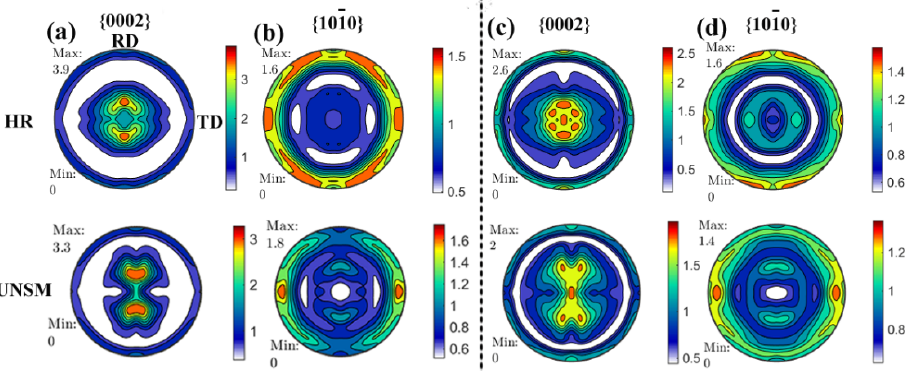
— Figure 5. {0002} and {1010} pole figures of LAE361 Mg-Li alloy ( a , b ) and LA106 Mg-Li alloy ( c , d ) before and after the UNSM treatment.